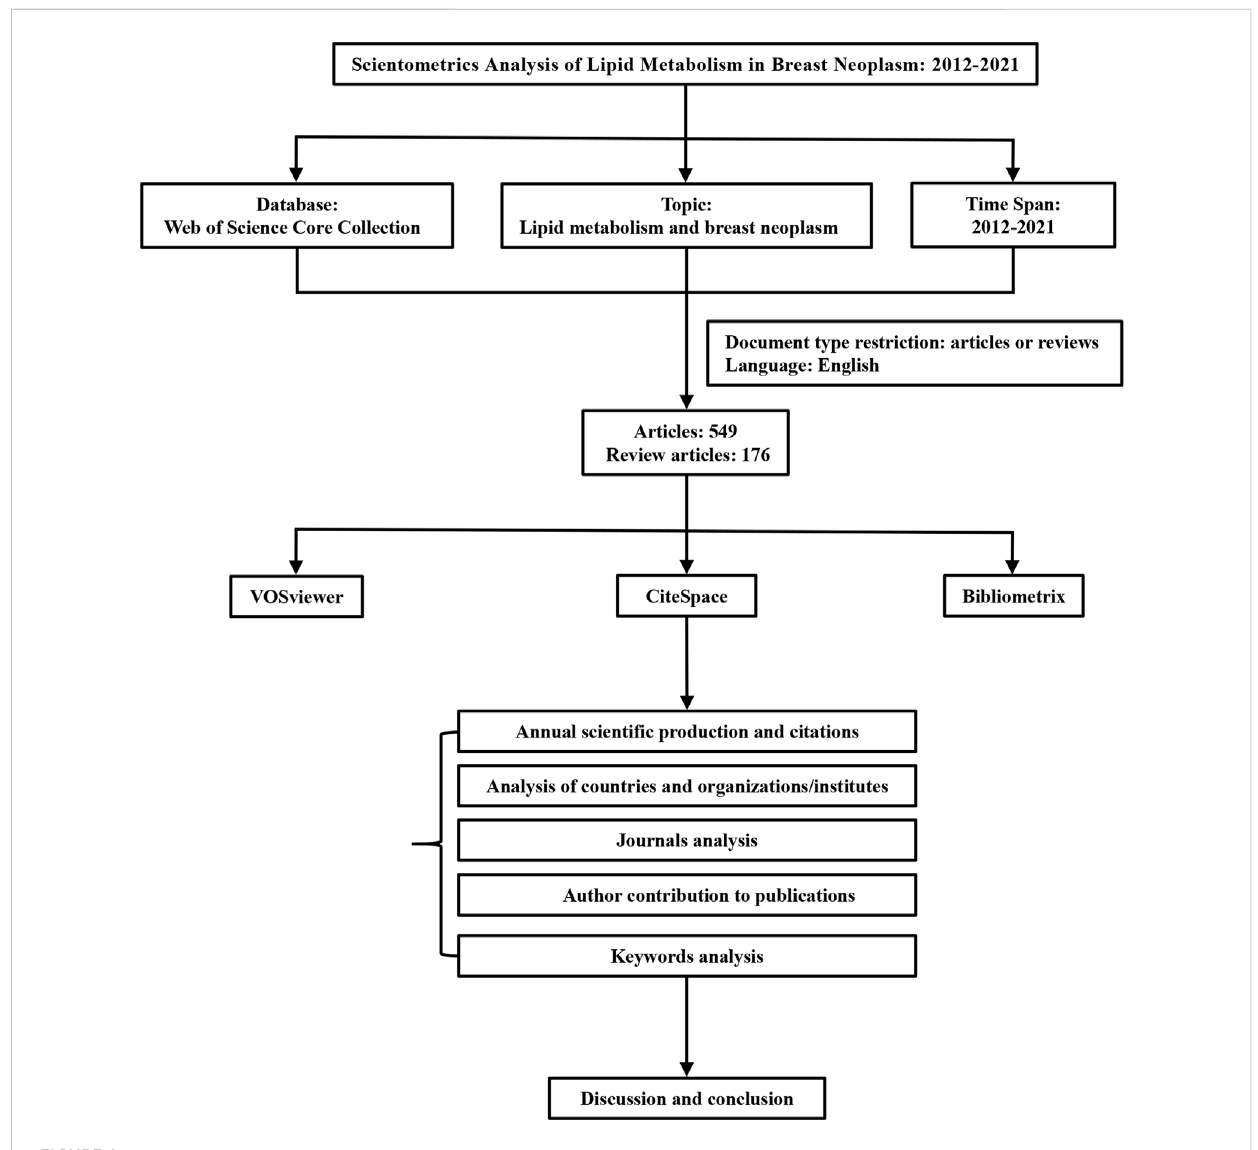
Flow chart of the scientometric